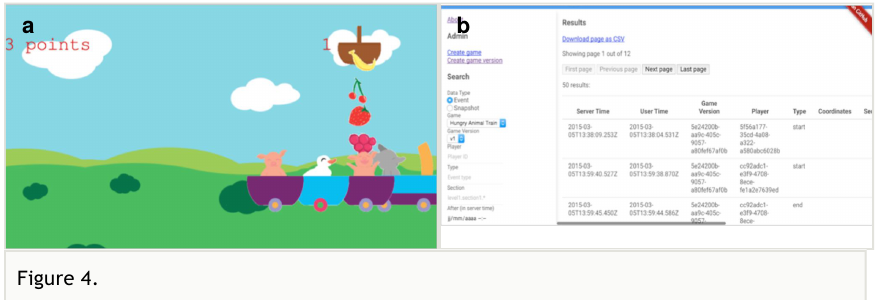
Figure 4. Screenshots of a RedWire game and its RedMetrics game analytics. Hungry Animal Train is a game created at the CRI Game Lab to study time estimation among children with autism. It was created entirely within RedWire, and publishes data about its use to the RedMetrics game analytics service, where researchers, developers, parents, and other interested partners can fi lter and download the data for statistical